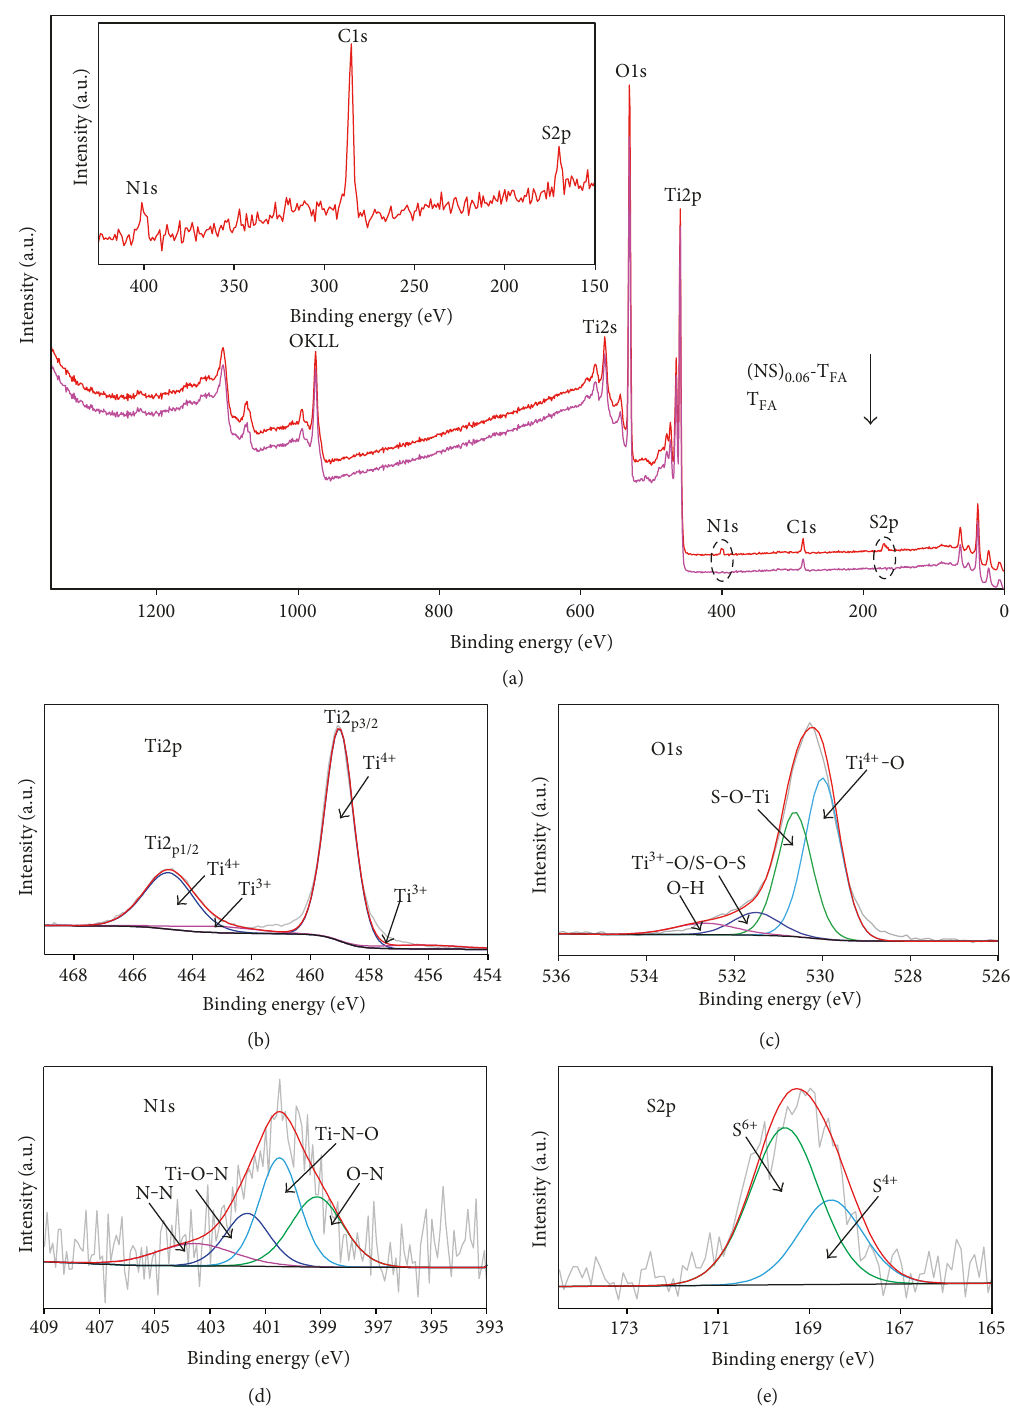
Figure 6: XPS spectra of (NS) -T and T powders. (a) Survey spectrum, insert (showing peaks for N1s, C1s, and S2p), (b) high-resolution 0.06 FA FA spectrum of Ti2p, (c) high-resolution spectrum of O1s, (d) high-resolution spectrum of N1s, and (e) high-resolution spectrum of